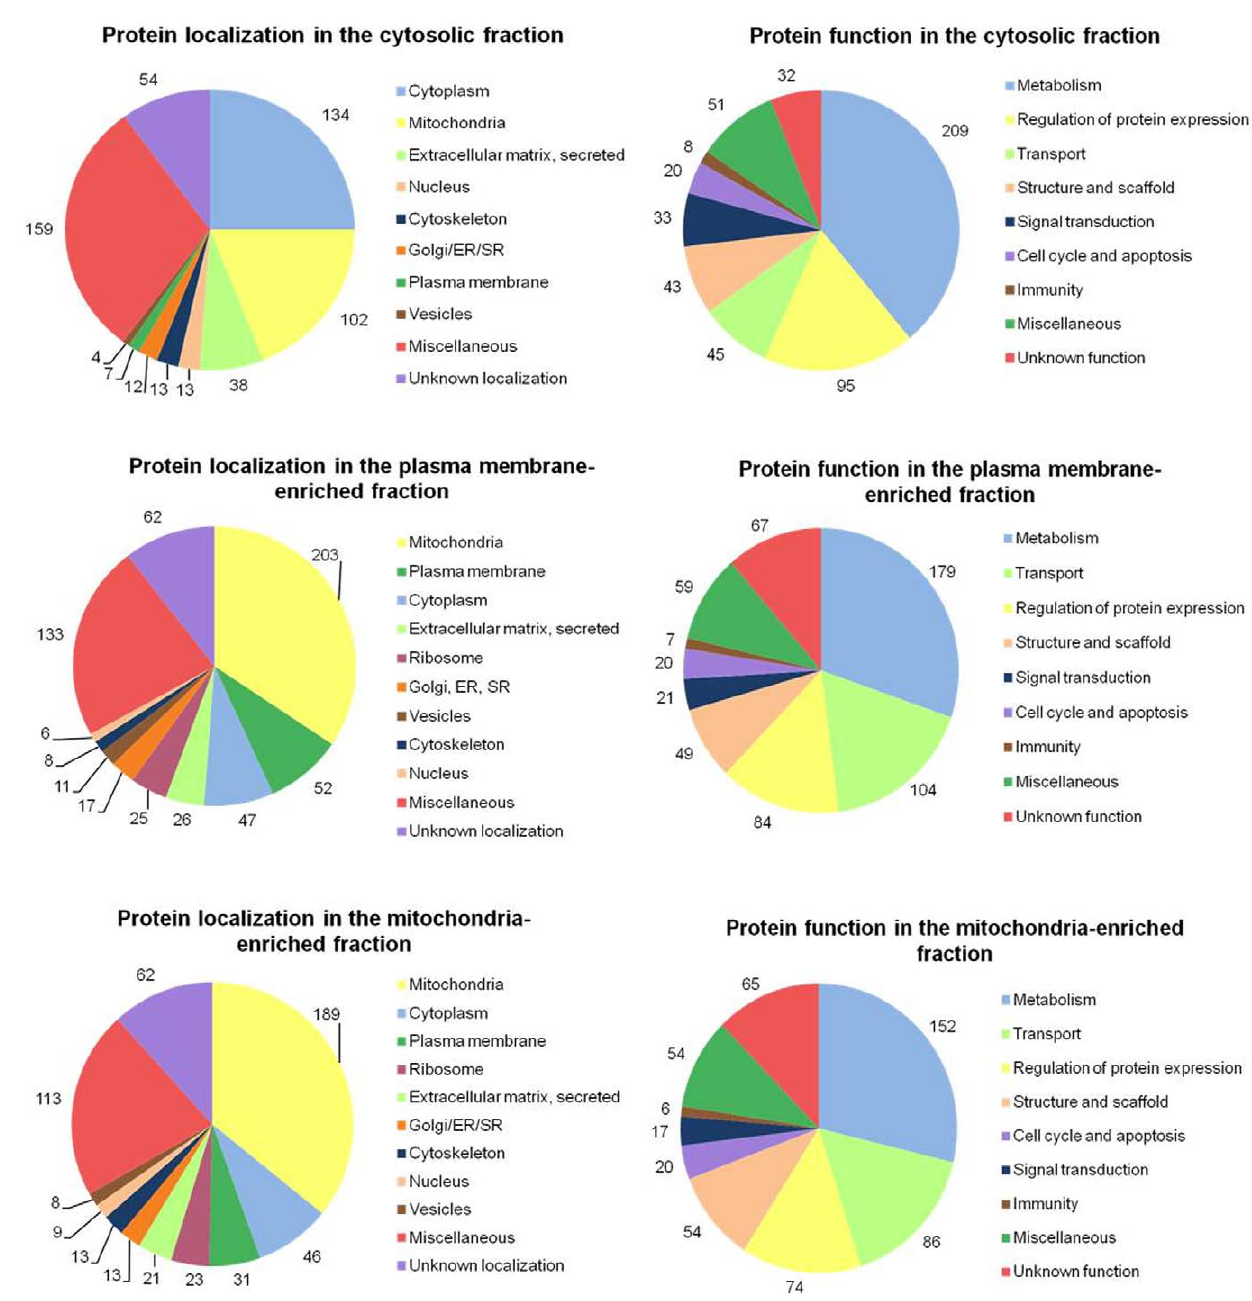
Figure 2. Classification of proteins identified in the left ventricular myocardium according to their subcellular localization and function. The proteins of each fraction (CT, PM and MT) isolated from hearts of control (C), morphine-treated (M), and morphine-withdrawn (M W -I and M W -II) rats were labeled by isobaric reagents provided in iTRAQ 4-plex reagent kit. After LC-MALDI analyses performed on Ultimate 3000 HPLC system and acquisition of spectra on 4800 Plus MALDI TOF/TOF analyzer, proteins were identified and quantified using Protein Pilot 4.0. Localization and function of the proteins were assigned on the basis of current annotations in the Swiss-Prot database. Sections of the pie charts represent the proportion of proteins found within each functional